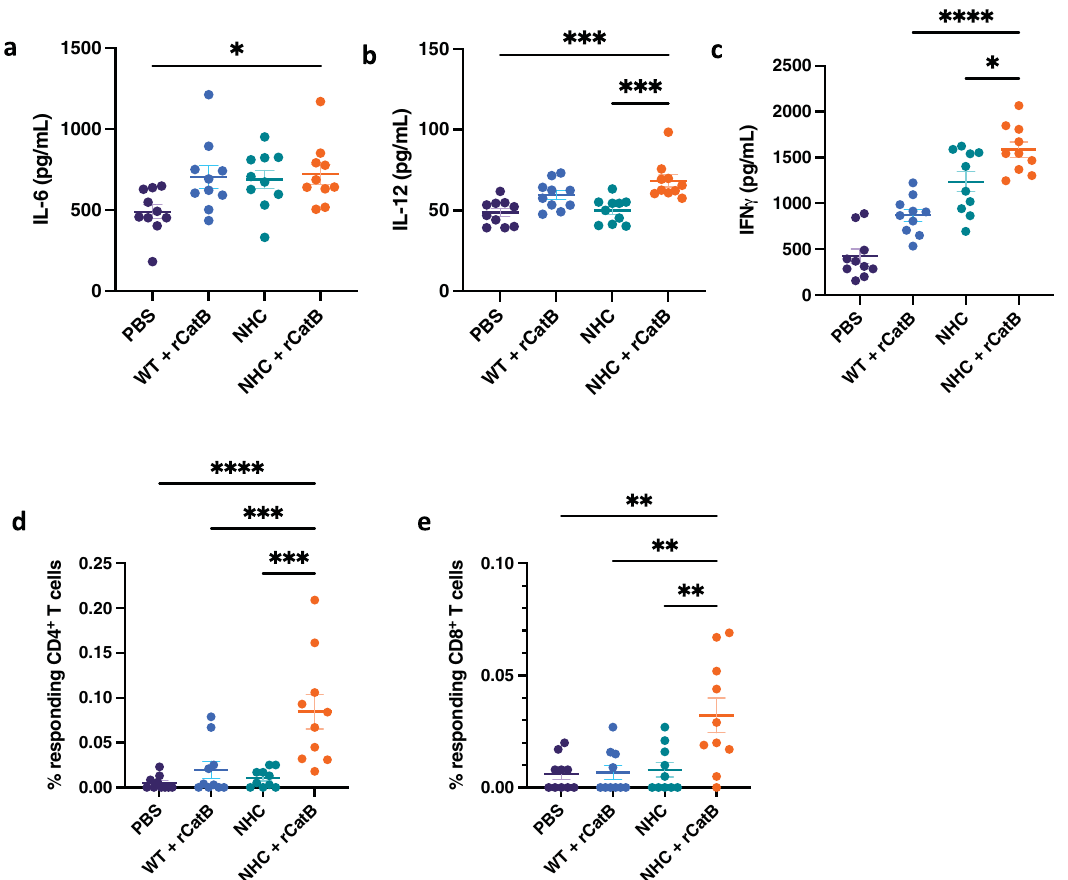
Fig. 3 Cellular responses. Supernatant levels of IL-6 ( a ), IL-12 ( b ), and IFN γ ( c ) after ex vivo restimulation of splenocytes with rCatB for 72 h. Cytokines were measured by Quansys multiplex ELISA and expressed in pg/mL. The percentage of responding IFN γ + CD4 + T cells ( d ) and IFN γ + CD8 + T cells ( e ) in ex vivo restimulated splenocytes with rCatB after 24 h were measured by fl ow cytometry. Each independent experiment consisted of fi ve animals per group. Each experiment was performed twice. Data were shown as mean ± SEM. For fl ow cytometric analysis, data are shown as mean ± SEM of net values after background subtraction with unstimulated cells. Statistical signi fi cance was determined by one-way ANOVA with Tukey ’ s multiple comparisons (* P < 0.05, ** P < 0.01, *** P < 0.001, and **** P <